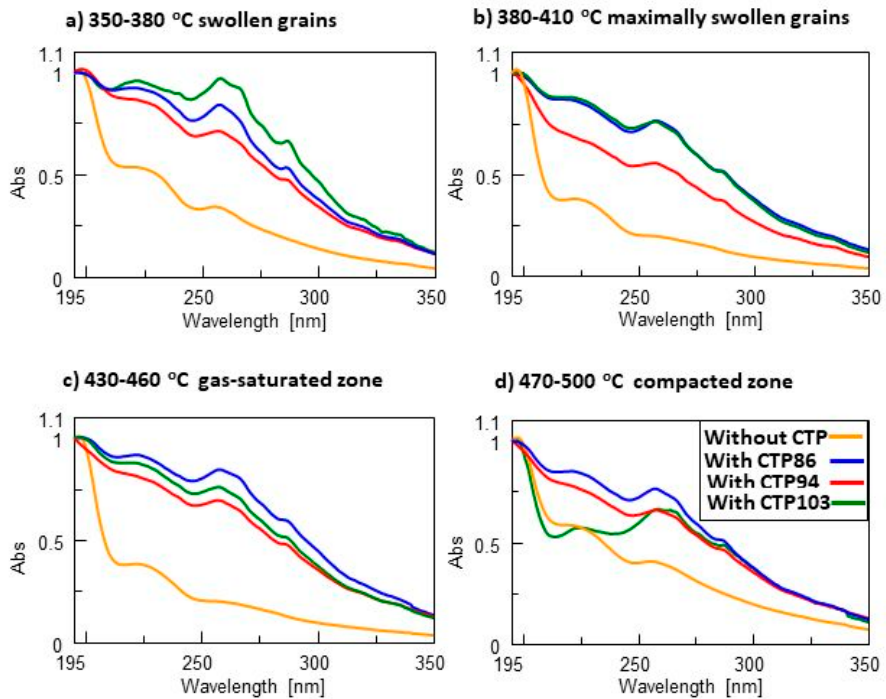
Figure 8. The normalized UV spectra of material that was rinsed from the surface of swollen grains ( a , b ) and extracted from the gas-saturated and compacted zones ( c , d ). The material from the zone of maximally swollen grains from the charge with